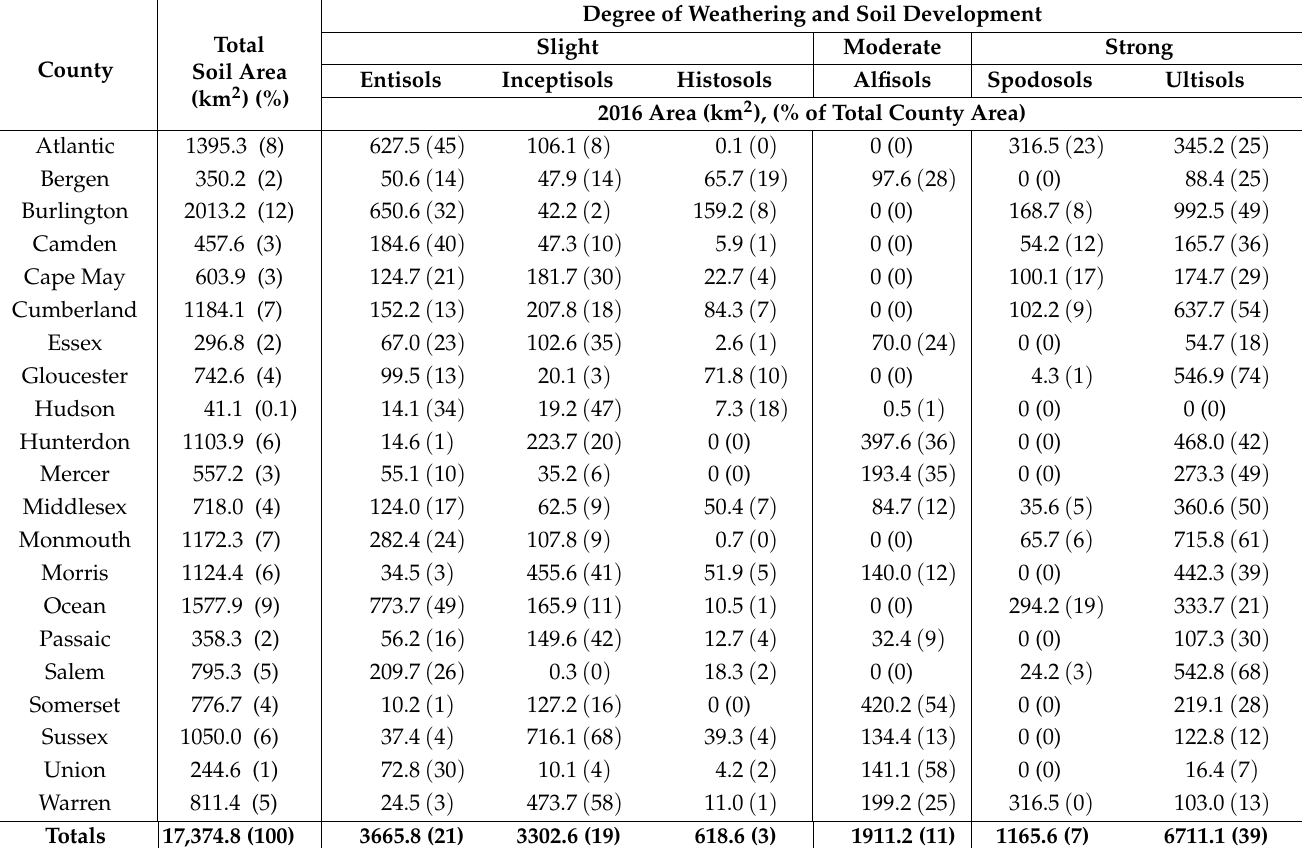
Table 3. Soil diversity by soil order and county for the State of New Jersey (USA) from the Soil Survey Geographic (SSURGO) Spatial Database